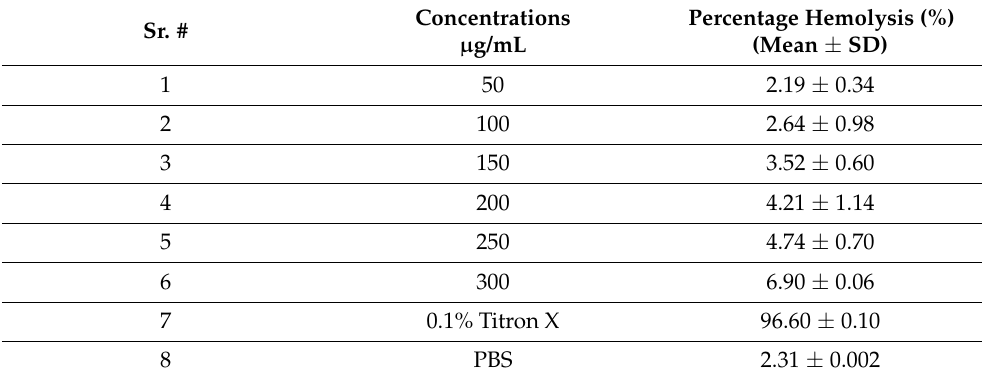
Table 4. The hemolytic potential of ZnO NPs of aqueous fraction of L. edodes methanolic extract. Sr. #